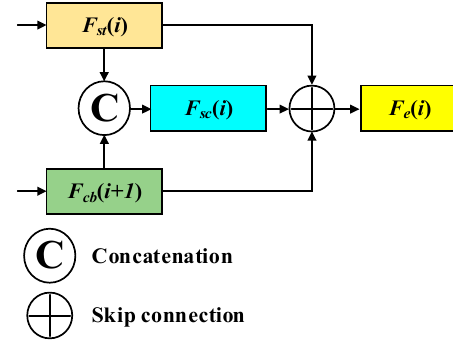
Figure 3. The Pipeline of EFA.